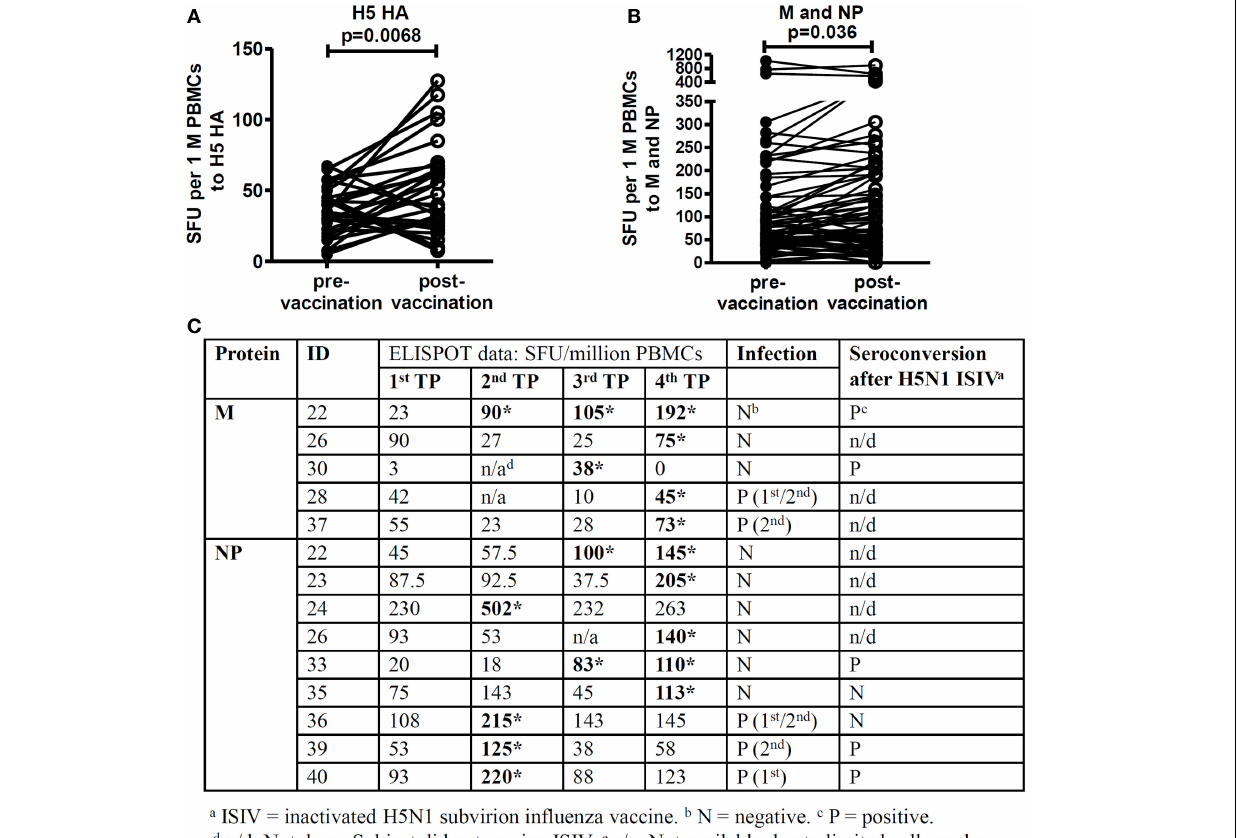
first and second vaccination ( n = 21). (B) Comparison of T cell responses targeting internal proteins M ( n = 20) and NP ( n = 19) pre- and post- first and second vaccination. p- values were calculated using the Wilcoxon matched-pairs signed rank test. (C) Study subjects who showed > 2-fold elevated T cell responses to M and NP peptides after